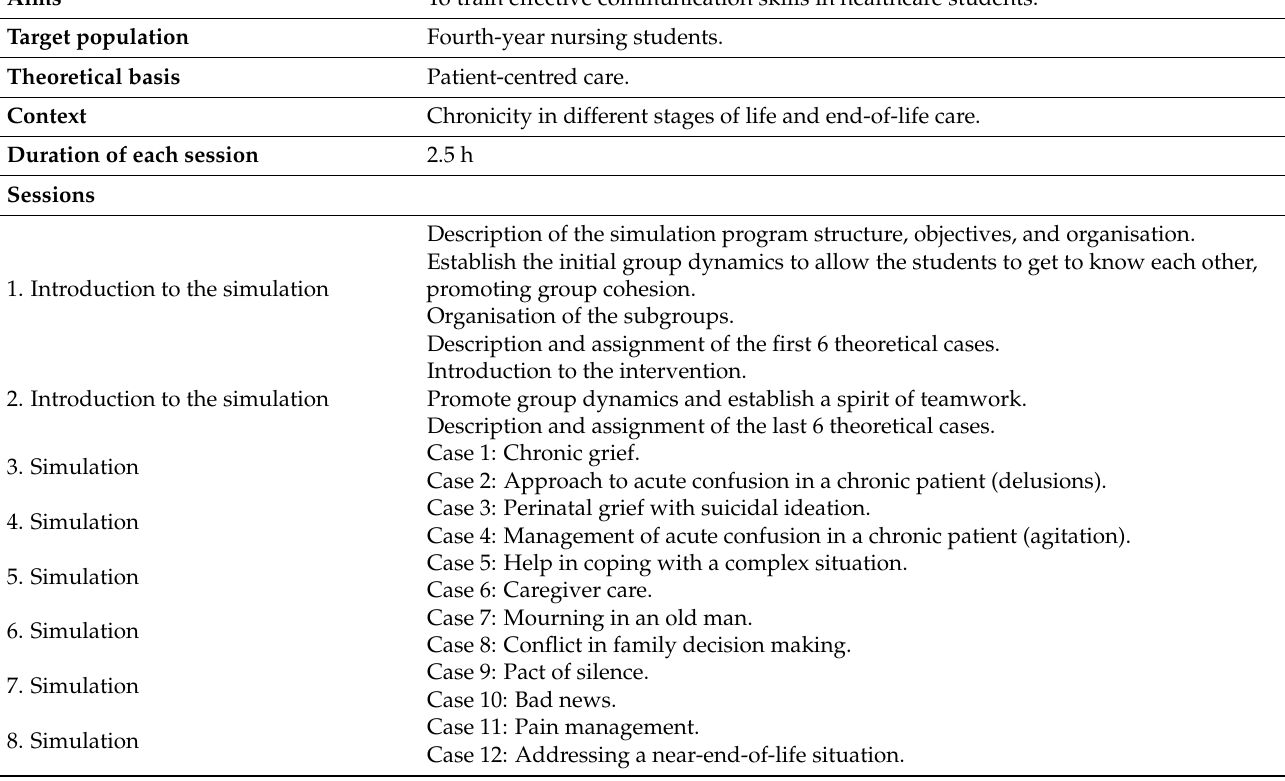
Table 1. Description of the high-fidelity simulation intervention using standardised patients implemented in this study. Aims To train effective communication skills in healthcare students. Target population Fourth-year nursing students. Theoretical basis Patient-centred care. Context Chronicity in different stages of life and end-of-life care. Duration of each session 2.5 h